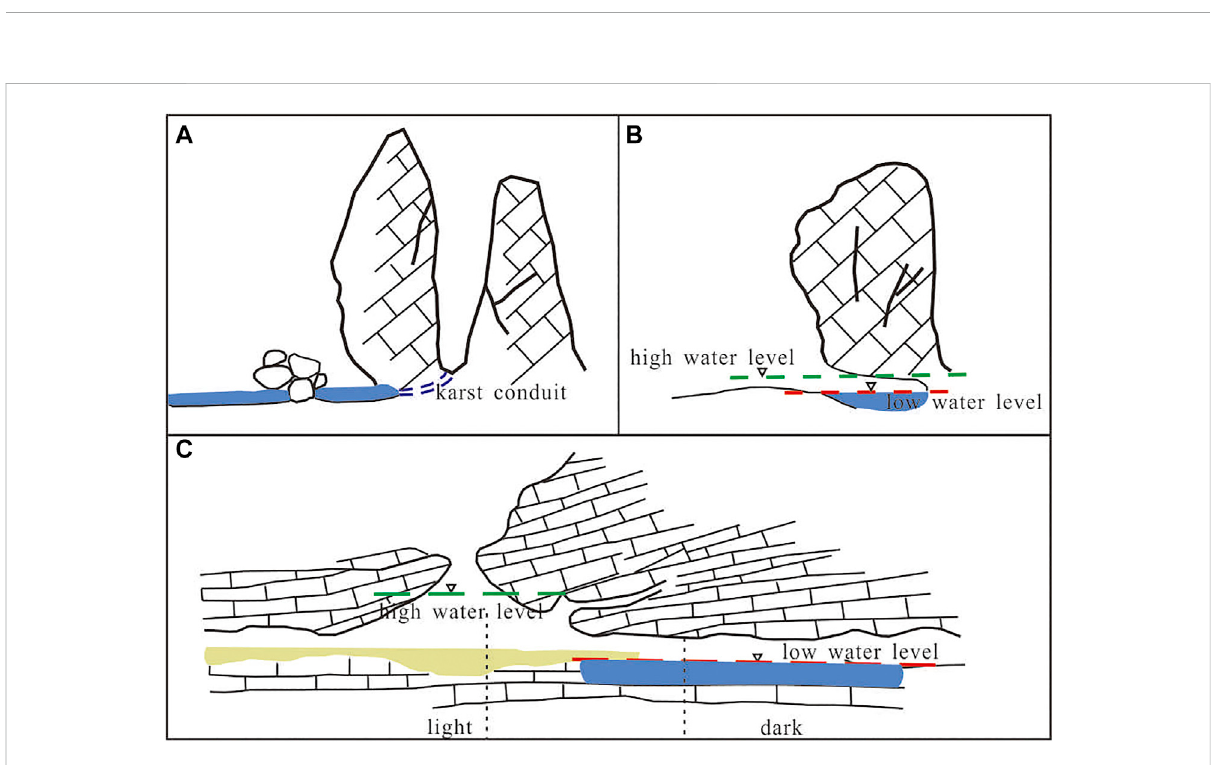
FIGURE 2 The sketch map of three main karst cave wetlands. (A) spring/subterranean river-type wetland; (B) foot-cave-type wetland; (C) karst window- type